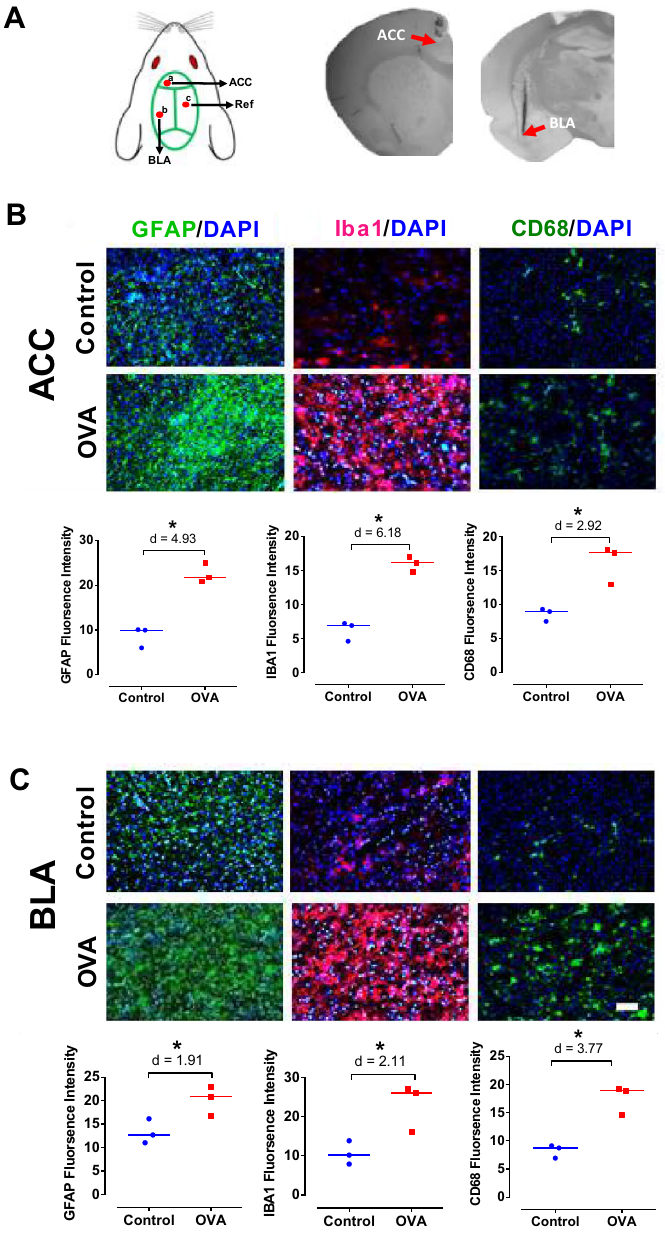
Figure 2. Inflammatory responses in brain. ( A ) Schematic illustration of electrode implantation sites (left panel) and histological verification of recording sites in ACC and BLA (right panel). ( B, C ) Immunofluorescence reactivity of microglia (CD68 and Iba1) and astrocytes (GFAP) counterstained with DAPI in ACC ( B ) and BLA ( C ), represented in raw images (upper panels) as well as quantitative values (lower panels). Scale bar represents 50 μm. The horizontal bars represent median values. Data were analyzed by Mann–Whitney test, n = 3 per group. *p < 0.05 compared to control. OVA, ovalbumin; ACC, anterior cingulate cortex; BLA, basolateral